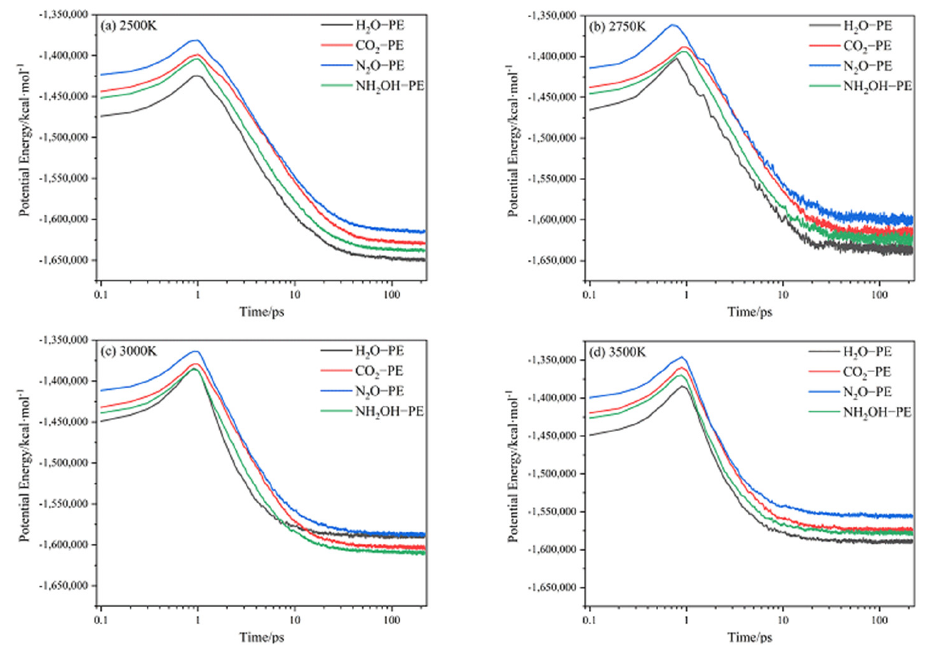
Figure 2. Evolution of potential energy of CL − 20/H 2 O, CL − 20/CO 2 , CL − 20/N 2 O, CL − 20/NH 2 OH system with time at ( a ) 2500 K, ( b ) 2750 K, ( c ) 3000 K, ( d ) 3500 K. Thick trendline corresponds to the actual concentration data of corresponding matching color.